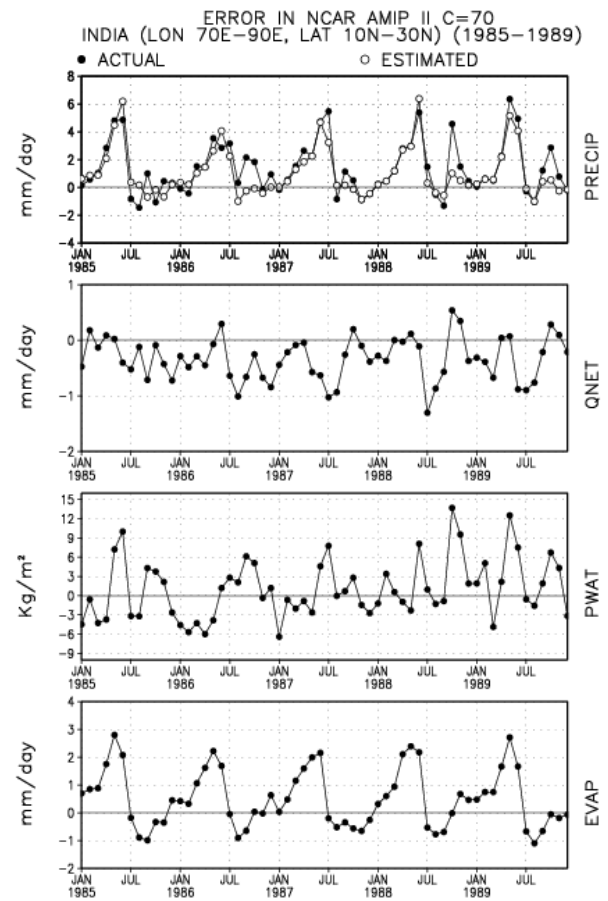
Fig. 10. Comparison between actual error in rainfall in NCAR GCM and the error in rainfall estimated from the simple model in the Indian region. Errors in Q net , P w and evaporation have also been